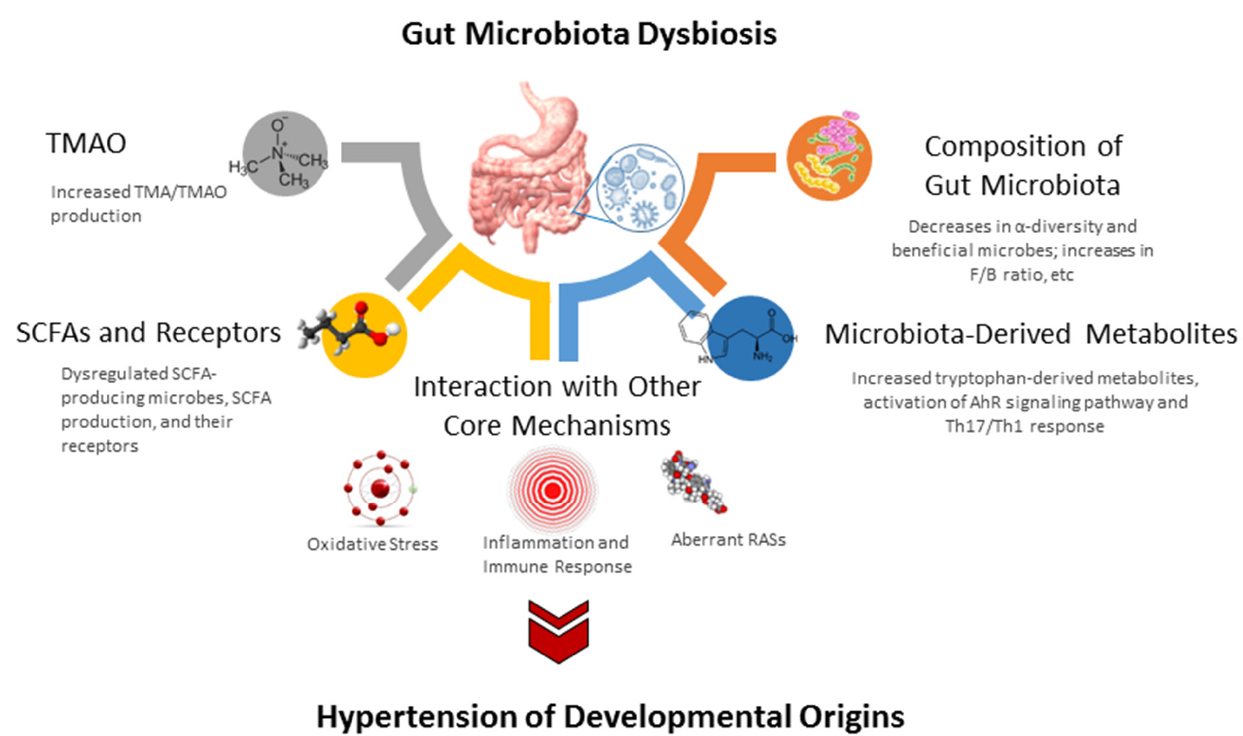
Figure 3. Overview of the gut microbiota and potential molecular mechanisms related to hypertension of developmental origins. SCFA short chain fatty acid. TMAO = trimethylamine N-oxide; TMA = trimethylamine; SCFA = short chain fatty acid; RAS = renin-angiotensin system; TH17 = T helper 17 cells; TH1 = T helper 1 cells; F/B ratio = Firmicutes to Bacteroidetes ratio; AhR = aryl hydrocarbon receptor.